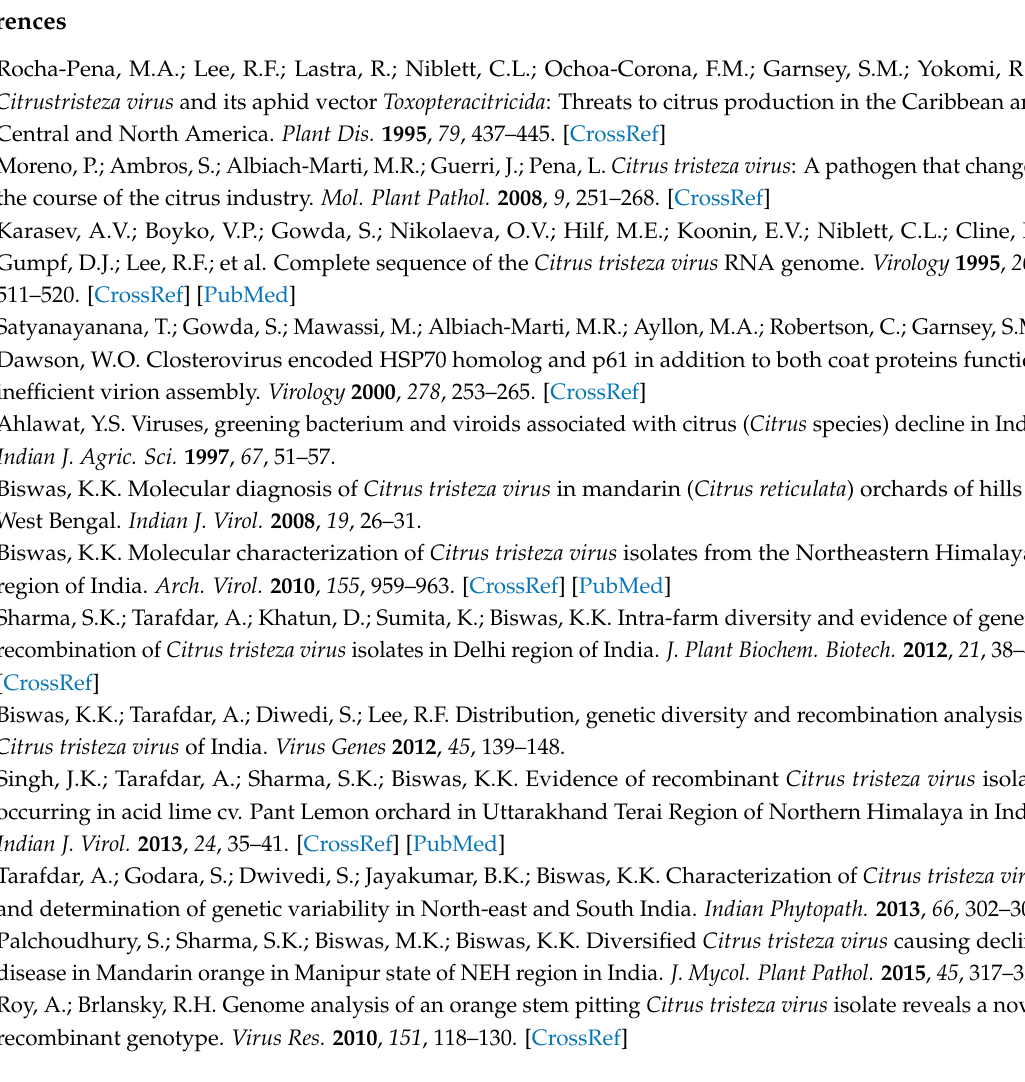
Table S1: Source of CTV isolates originated in different citrus species used in the present study; Table S2: Nucleotide contents of CP genes of 122 CTV isolates; Table S3: Contribution of host-preferred high-frequency codons, virus-preferred high-frequency codons, and other synonymous codons in coat protein of CTV isolates. Author Contributions: Conceived and designed the experiments: K.K.B., S.P. and P.C.; performed the